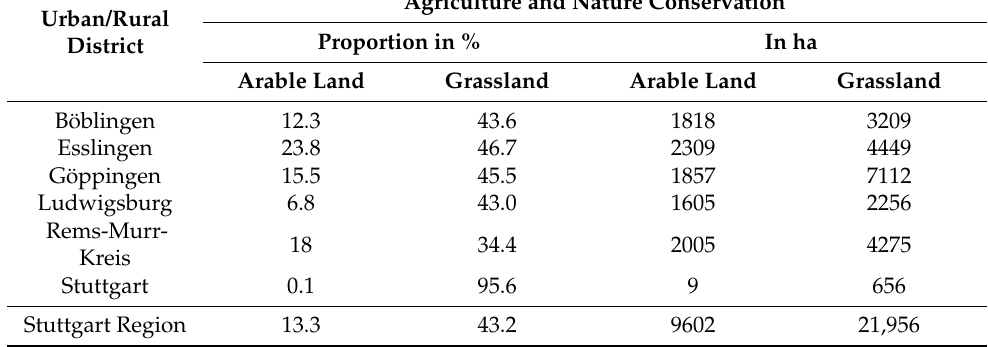
Table 9. Proportion of arable land and grassland in % and in ha that is suitable for the implementation of PIC from the perspective of both nature conservation and agriculture. Land with at Least One Shared Suggested Option from the Perspective of